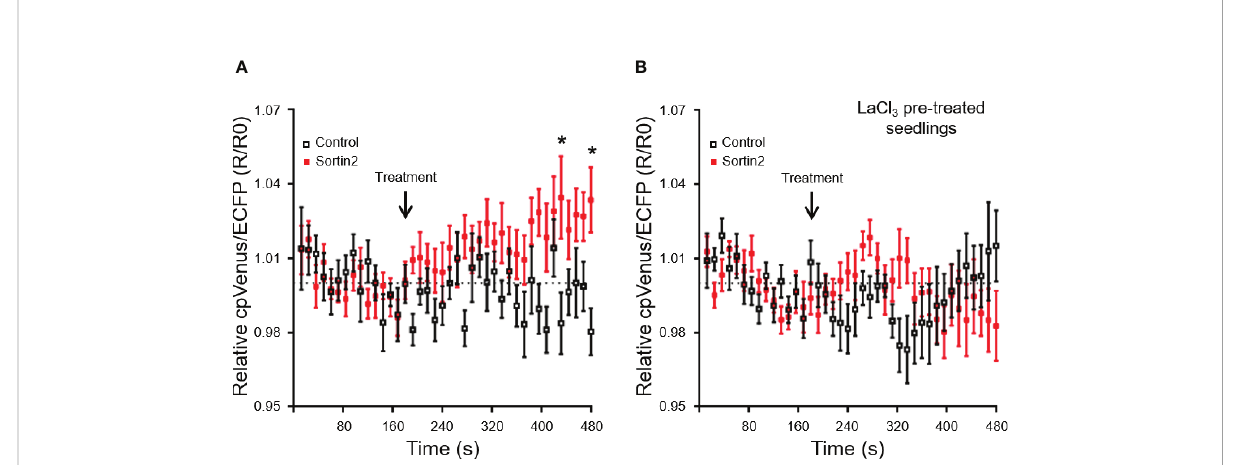
FIGURE 6 Sortin2 treatment increases cytoplasmic Ca 2+ levels in the primary root. (A) Five-day-old seedlings of the cytoplasmic Ca 2+ reporter line NES- YC3.6 were incubated in a perfusion chamber. ECFP and cpVenus fl uorescence in the root differentiation zone was analyzed by confocal microscopy to determine the cytoplasmic Ca 2+ level. Seedlings were incubated with MSL containing 1% DMSO (time 0) and imaged for 180 seconds. Then, seedlings were treated with MSL supplemented with Sortin2 (red) or 1% DMSO (control, black) and recorded for 300 seconds. (B) Five-day-old seedlings were treated with LaCl 3 (1 mM) for 1 hour before being placed in the chamber. The treatment and recording were performed in conditions similar to those described in (A) The normalized ECFP/cpVenus ratio from three independent experiments is shown ( n = 12 seedlings). The dashed line indicates a normalized ratio value of 1.0. Results were analyzed using two-way ANOVA with Sidak post-hoc tests. Only statistically signi fi cant differences between the Sortin2 and control treatments are indicated (* p <